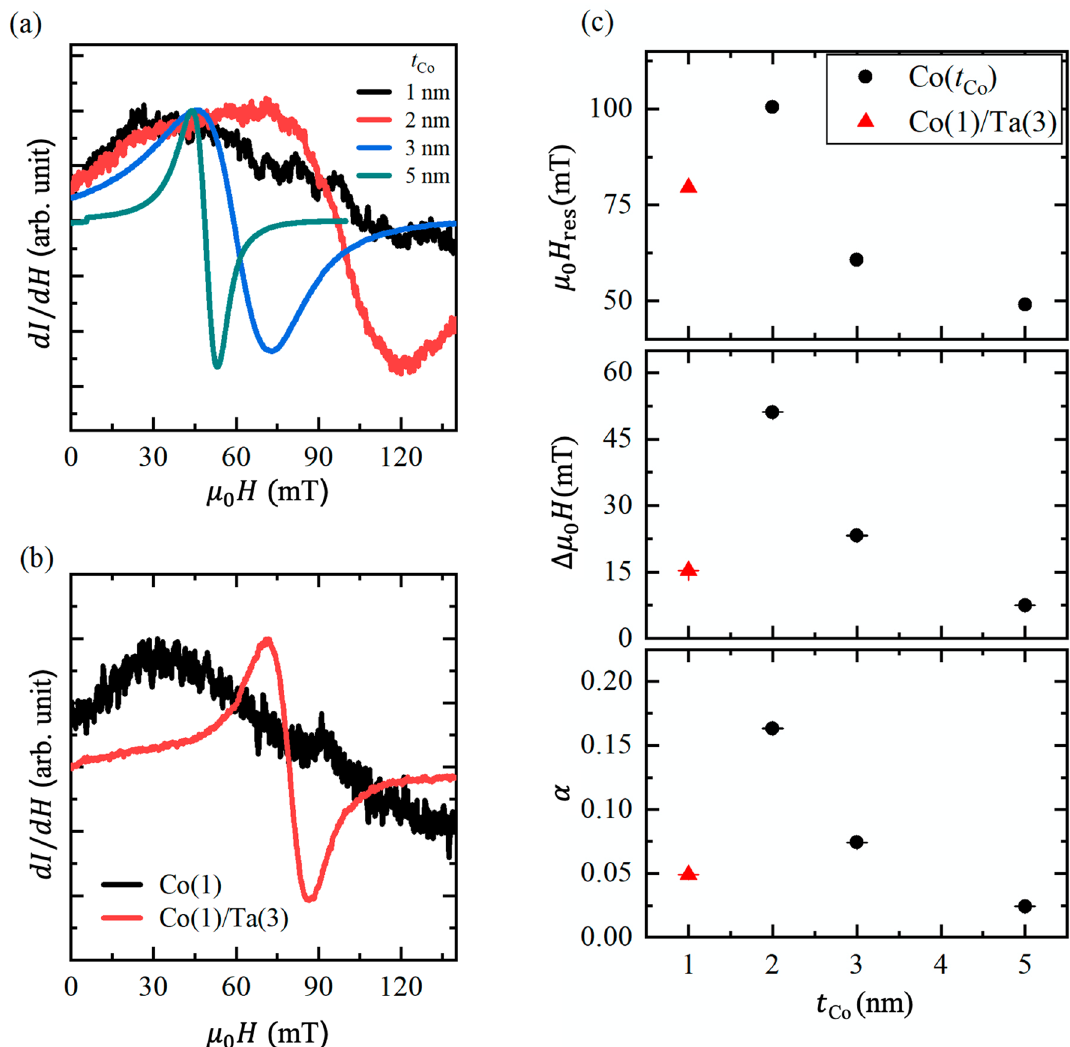
Figure 2. ( a ) FMR spectra of sample-A Co of 1, 2, 3, and 5 nm in thickness. ( b ) Comparison of the MR spectra of the Co (1 nm) and Co (1 nm)/Ta (3 nm) samples. ( c ) The Co thickness dependence of the resonance field μ 0 H res (upper panel), the half-width at half-maximum of the FMR spectra ΔH (middle panel), and the Gilbert damping constant α (lower